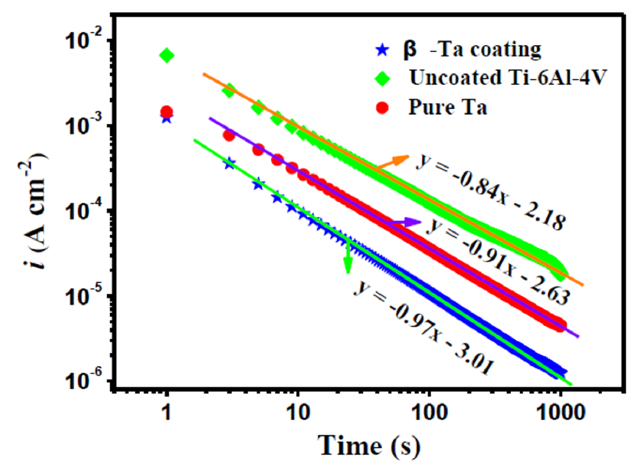
Figure 8. Current density vs. polarization time for the β -Ta coating, uncoated Ti-6Al-4V and commercially pure Ta potentiostatically polarized at 0.8 V in Hank’s solution at 37 °C.